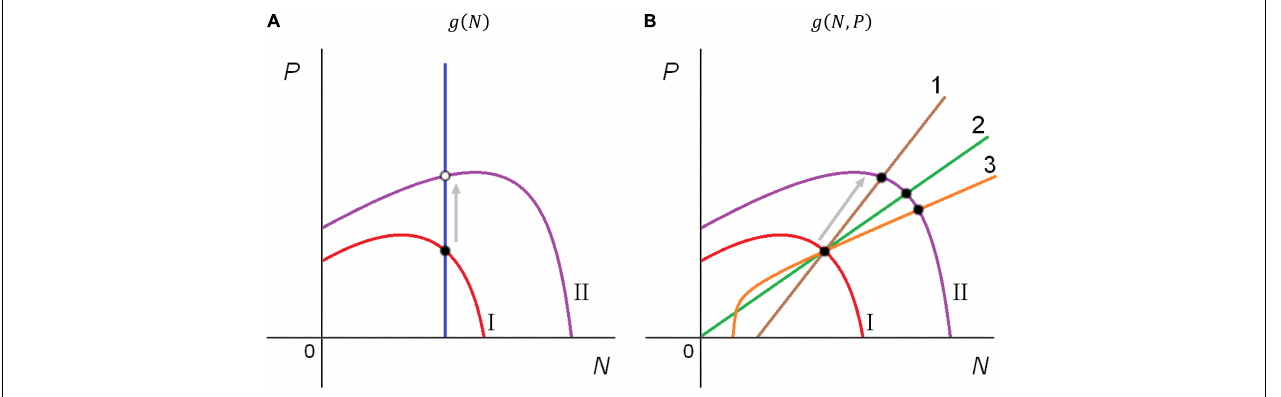
FIGURE 1 | Responding to prey enrichment, the prey zero-isocline in the predator-prey model changes its shape and position from I to II. Due to the verticality of the predator isocline in the prey-dependent models (A) , enrichment increases the predator equilibrium abundance but not the prey equilibrium; the initially stable equilibrium can become unstable. Slanted predator isoclines preserve the stability of the initially stable equilibrium in various predator-dependent models (B) . Lines 1, 2, and 3 show the predator zero-isoclines for the Beddington-DeAngelis, ratio-dependent, and gradual interference trophic functions, respectively. Solid and hollow points mark stable and unstable equilibria, respectively. Refer to the text for further details. ( Table 1 ) from the experimental data (Arditi and